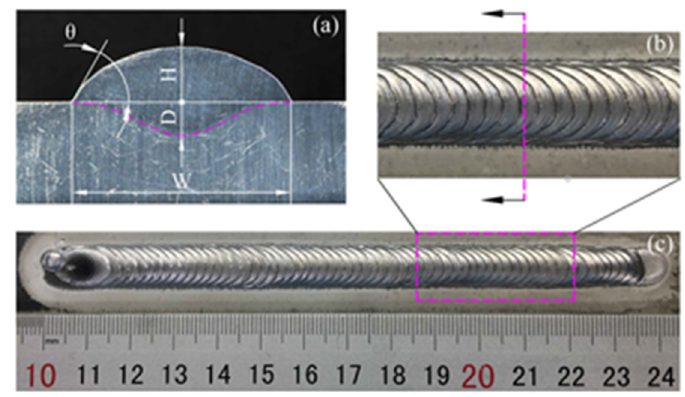
Figure 2. GTA-assisted DDM experiment platform. ( a ) Schematic diagram; ( b ) physical diagram. Table 1. The chemical composition of melted material (wt.%).